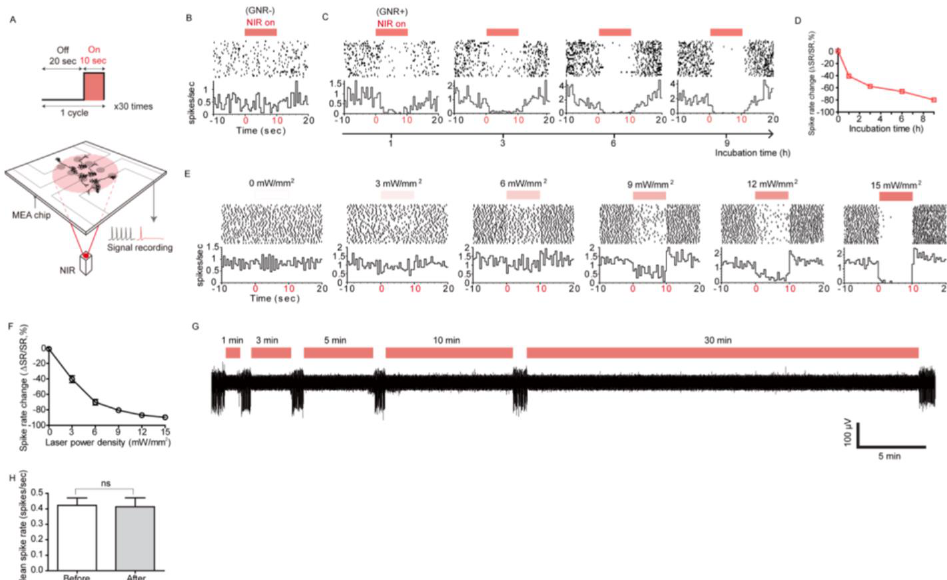
Figure 17. Photothermal modulation of spontaneous neural activity. ( A ) Schematic of repeated GNR-mediated photothermal stimulation of a neuronal network. Neurons were treated with 10 µ g / mL of NH2-PEG-GNRs, thenirradiated with an NIR laser multiple times (785 nm, 0–15 mW / mm 2 ). ( B ) Spike rates of untreated neurons when repeatedly irradiated with an NIR laser (15 mW / mm 2 ). ( C ) NIR radiation (15 mW / mm 2 ) pike rates of NH2-PEG-GNR-treated neurons that had varying incubation times. ( D ) A chart of GNR-treated neuron spike rates after the multiple NIR irradiations, shown in ( C ). One way ANOVA testing ( p < 0.0001) showed that n = 264, 74, 97, 99, and 98 at 0 h, 1 h, 3 h, 6 h, and 9 h, respectively. The data point for 0h corresponds to no PNF treatment, as shown in ( B ). ( E ) Peri-event histograms and raster plots for GNR-treated neurons, incubated for 9 h, that were irradiated at multiple laser power densities. ( F ) Chart of spike rate changes from the experiments recorded in ( E ). One way ANOVA testing was conducted on the neurons tested in ( E ) for each laser power density. The results were as follows ( p < 0.0001): n = 53 at 0 mW / mm 2 , 54 at 3 mW / mm 2 , 54 at 6 mW / mm 2 , 54 at 9 mW / mm 2 , 58 at 12 mW / mm 2 , and 58 at 15 mW / mm 2 . ( G ) A single trace of spike recording for di ff erent NIR irradiation periods (GNR incubation: 9 h, laser power density: 15 mW / mm 2 ). ( H ) Mean spike rates of GNR-treated neurons before and after NIR irradiation (Data collected from the channels in which neuron activities were completely suppressed during NIR irradiation, two-tailed unpaired t test; p = 0.9064, n = 40 for each bar). Reproduced with permission from [17]. American Chemical Society,